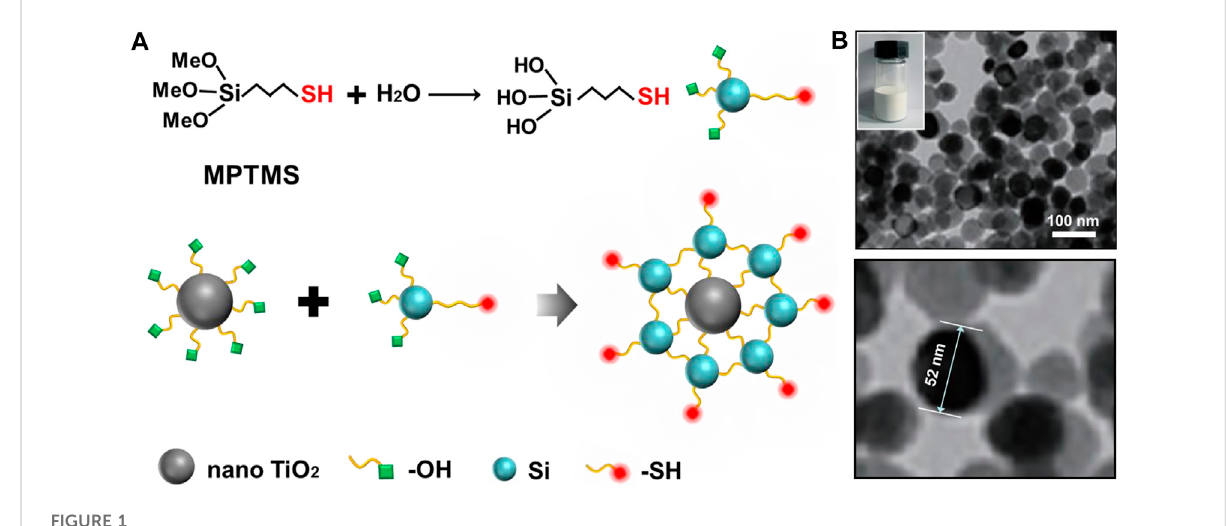
FIGURE 1 (A) ThepreparationmechanismandstructurediagramofnanoTiO 2 -SH. (B) TEMimageofnanoTiO 2 -SH,insetisanopticalphotographofnano TiO 2